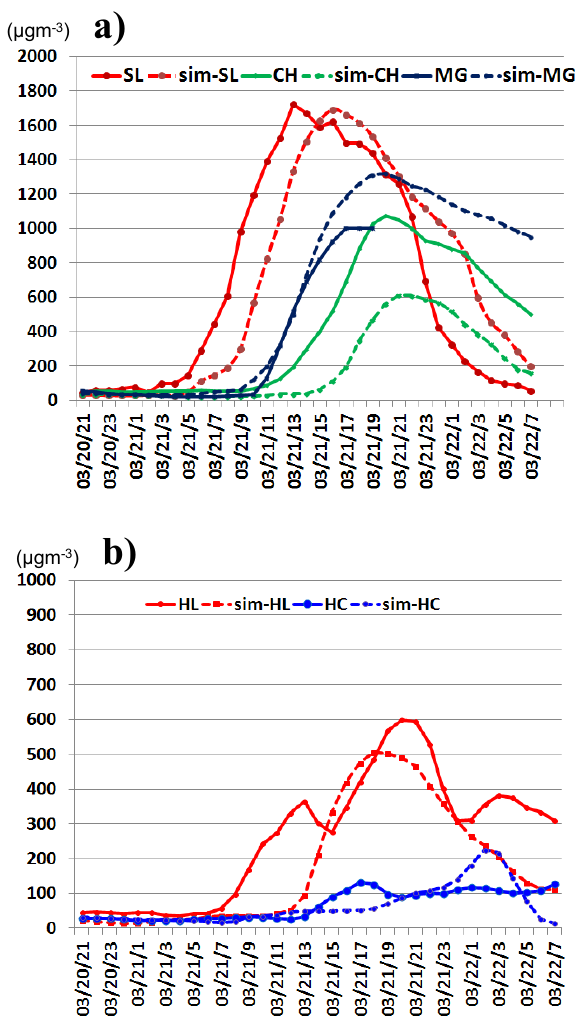
Fig. 8. Temporal variation of observation (solid) and simulation (dashed) PM 10 concentration around Taiwan at stations, SL, CH, MG, HL and HC from 21:00LST, 20 March to 07:00LST, 22 March 2010.